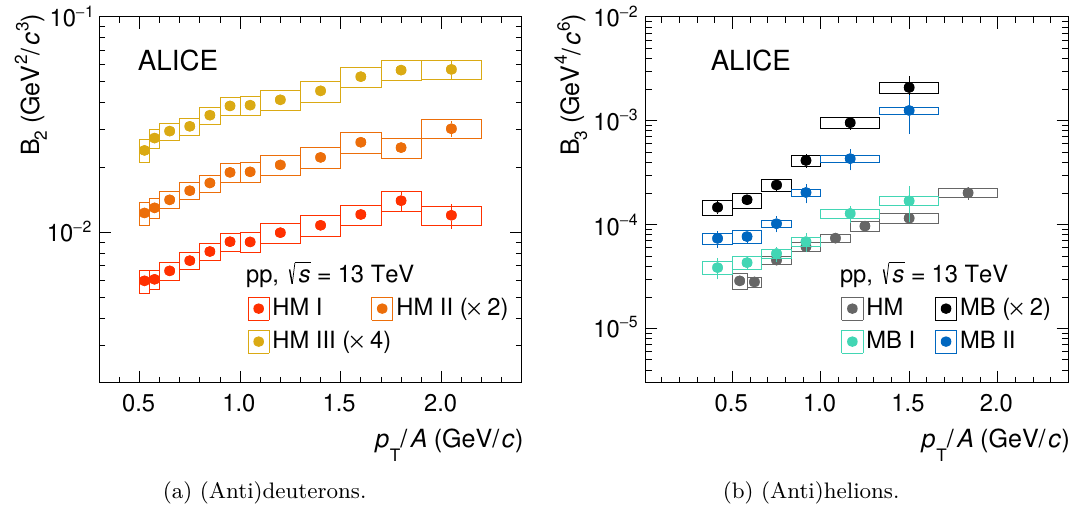
Figure 2. Coalescence parameters B 2 (a) and B 3 (b) as a function of p T /A for the multiplicity classes reported in table 2. Vertical bars and boxes represent statistical and systematic uncertainties,